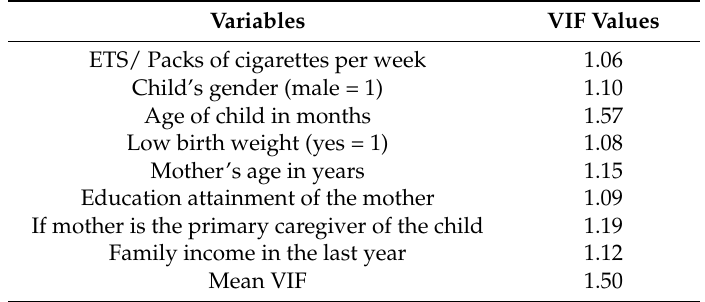
Table A1. The VIF values of the multicollinearity test of linear regression model with confounding